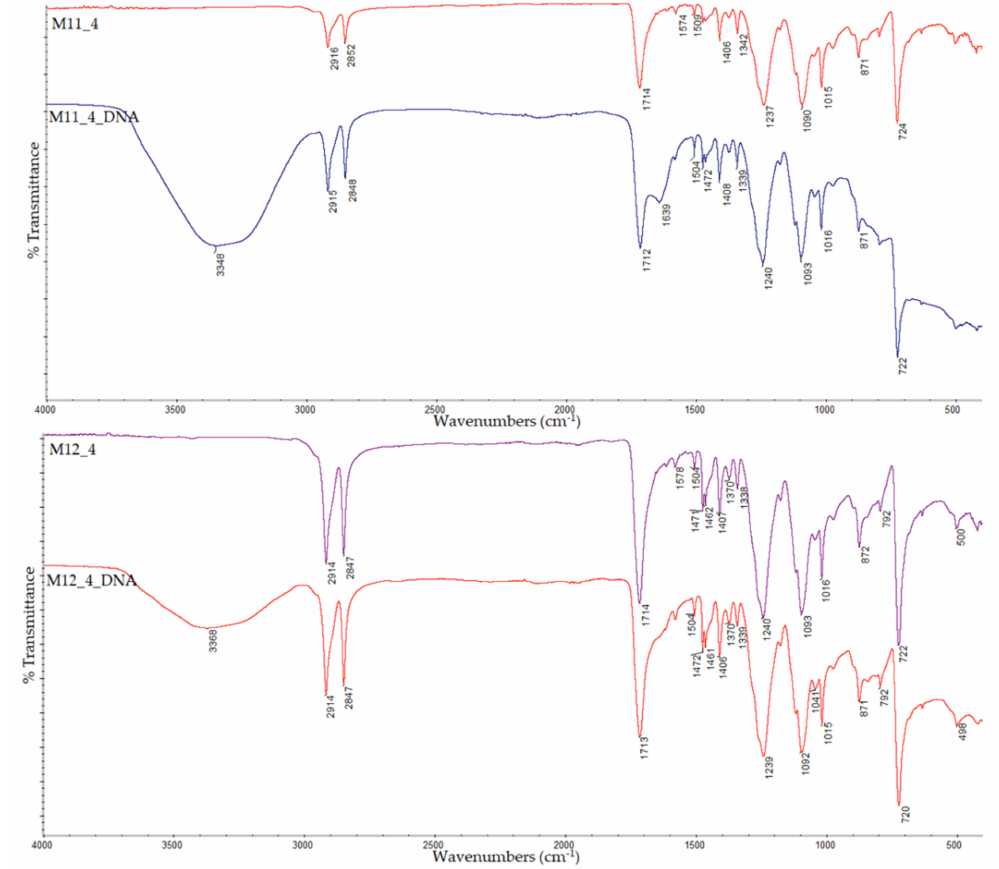
Figure 7. ATR–IR spectra of the bare PET and HDPE blended sample (M11_4), Al nanopow- der PET and HDPE blended sample (M12_4), and DNA − contaminated samples (M11_4_DNA and